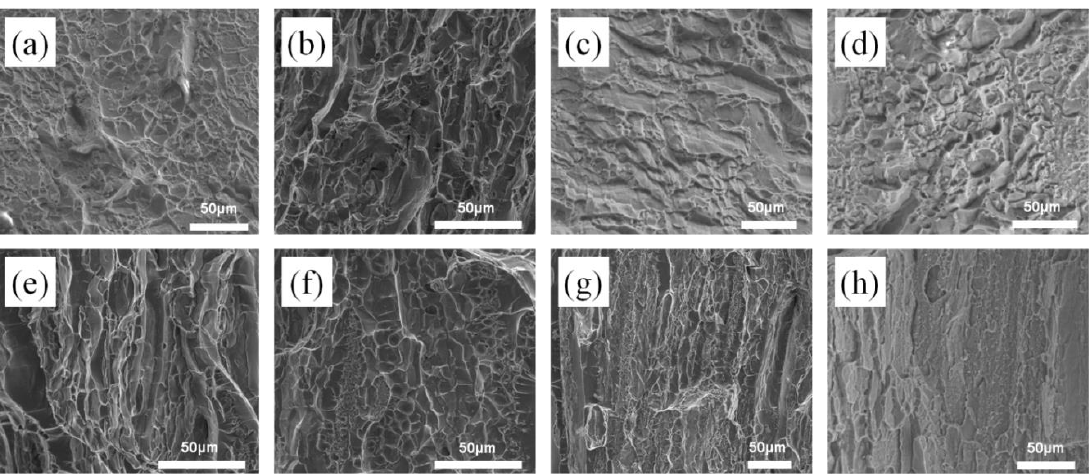
Figure 7. SEM images of the fracture morphology of the alloys: ( a , e ) 0.98 wt.%Cu; ( b , f ) 1.45 wt.%Cu;